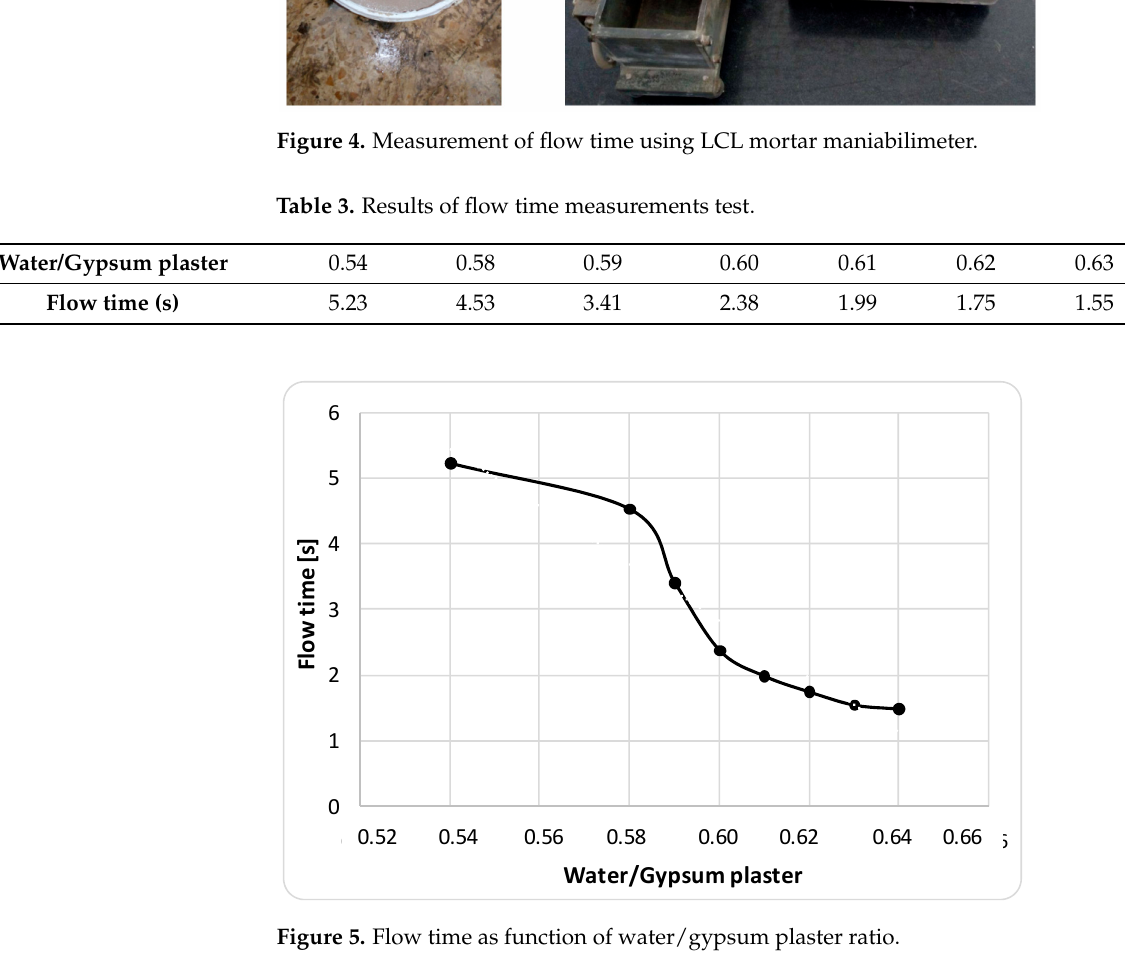
Figure 4. Measurement of flow time using LCL mortar maniabilimeter.